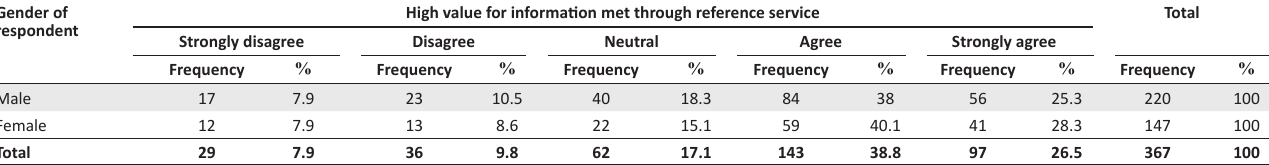
TABLE 3: Gender and value for information needs to be met through a face-to-face reference service. Gender of respondent